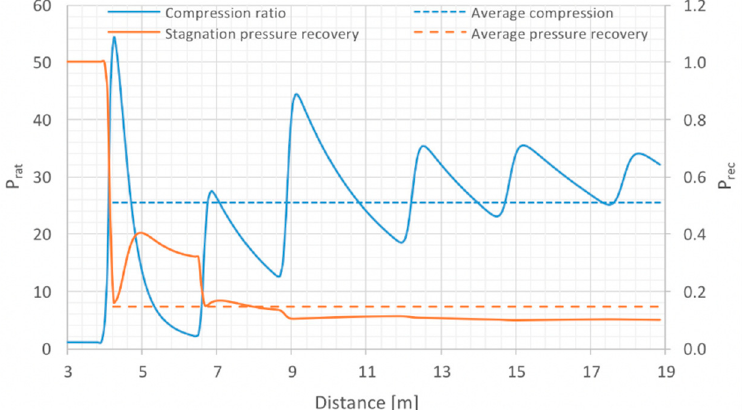
Figure 25. Performance of inlet in CFD at Mach 8.